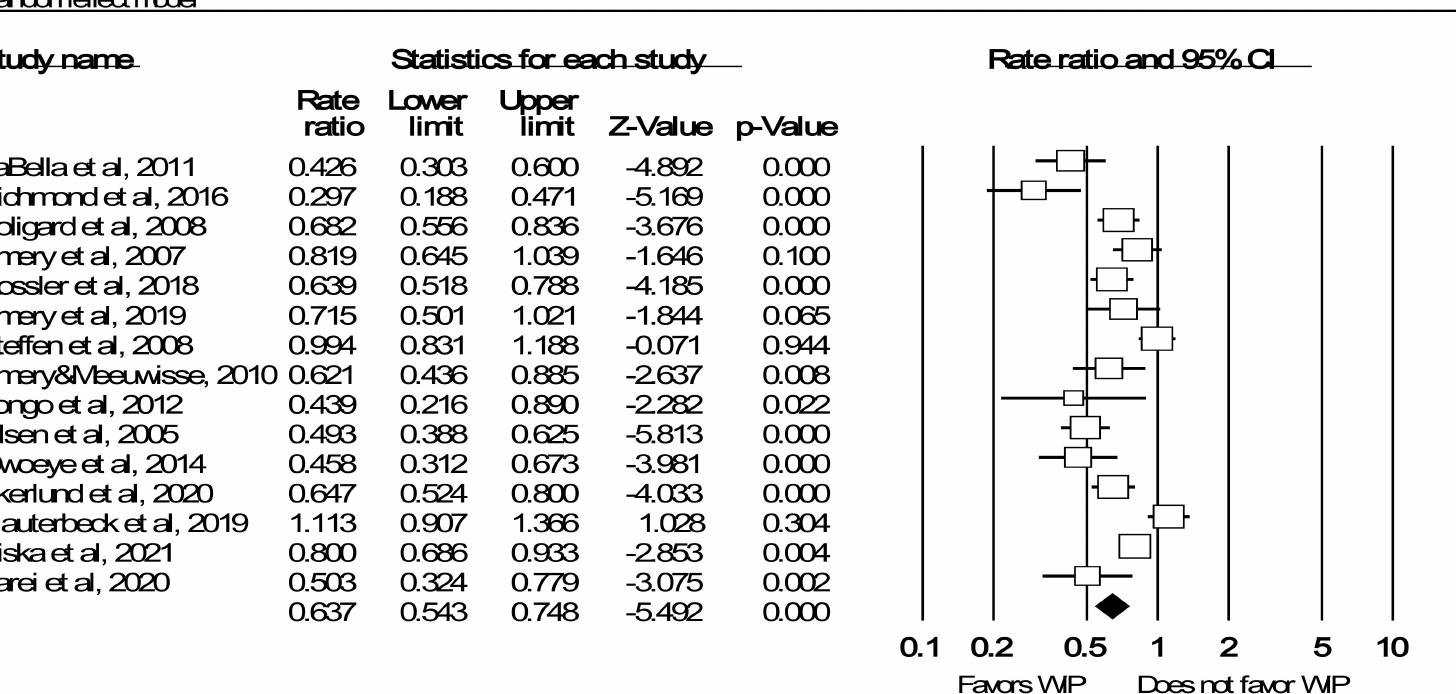
Figure 3. Forest plot illustrating the pooled effect of warm-up intervention program (WIP) as compared with controls on